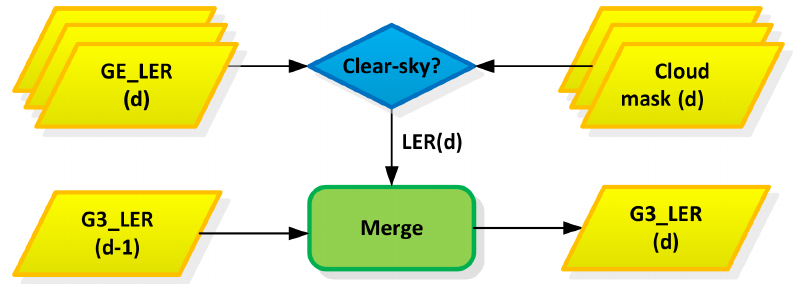
Figure 3. Data flow diagram for the creation of the global gapless geometry-dependent LER (G3_LER) map for day, d, obtained by merging the clear-sky LER data from the same day with the G3_LER map from the previous day.